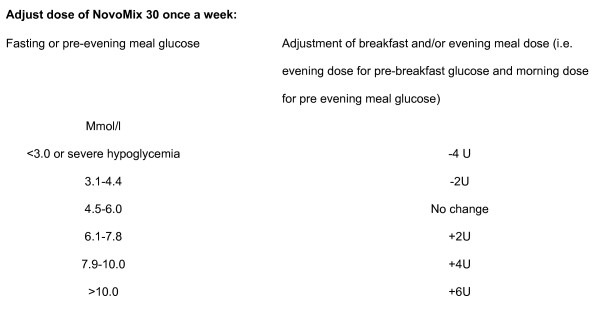
Insulin treatment.